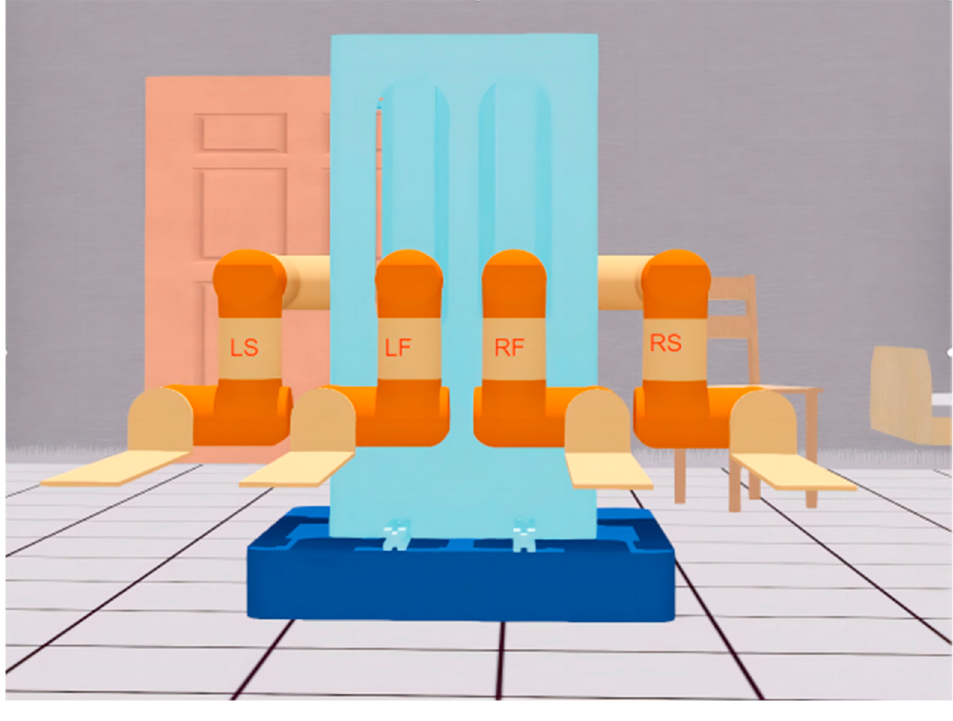
Figure 16. Webots model of four-manipulator handling robot.